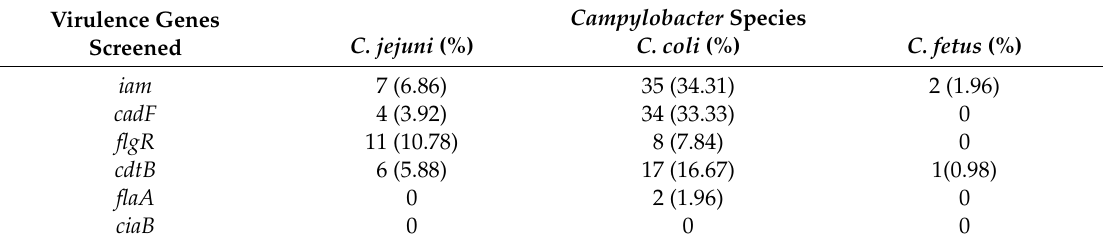
Table 3. Percentage distribution pattern of detected virulence genes in the identified Campylobacter species.